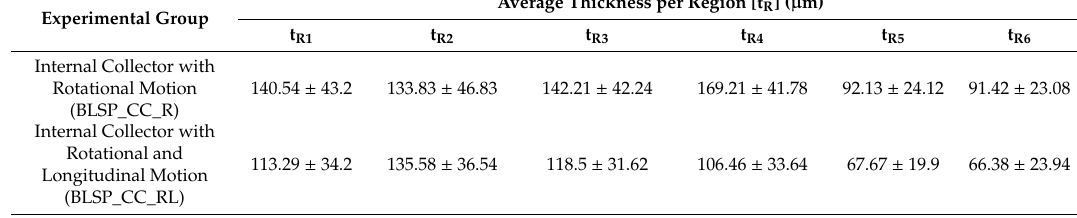
Figure 16. Membrane thickness distribution along the vascular graft membrane surface. (A two-way ANOVA was performed to determine any statistically significant differences between experiments.).